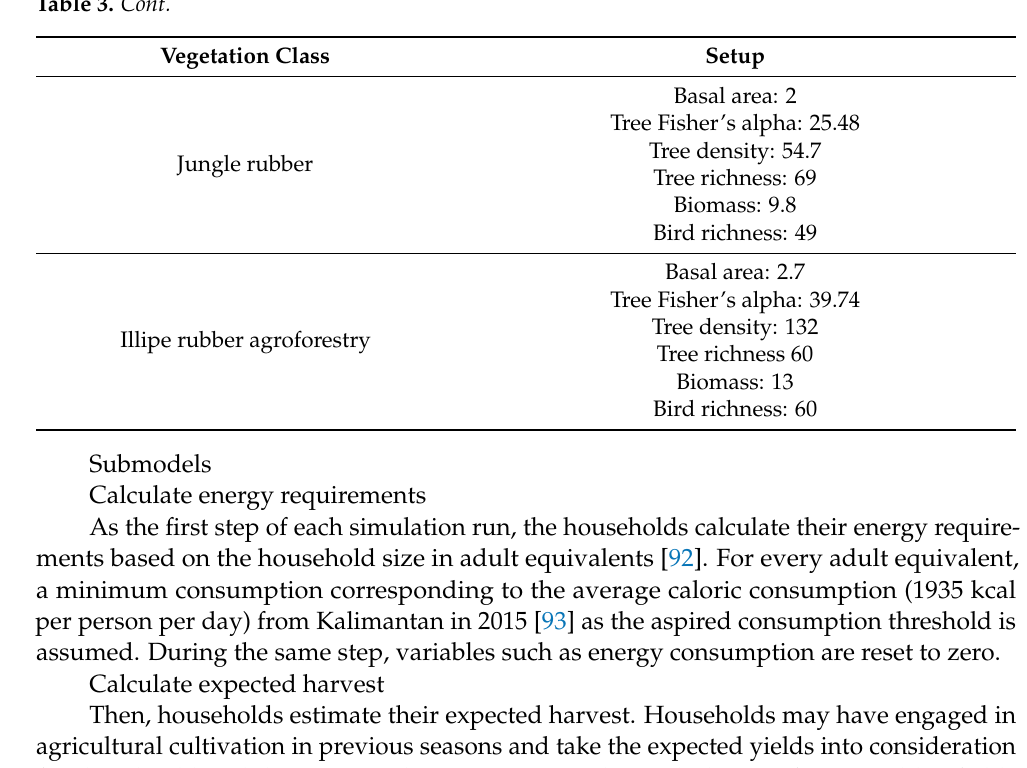
Table 3. Cont. Vegetation Class Setup Jungle rubber Illipe rubber agroforestry